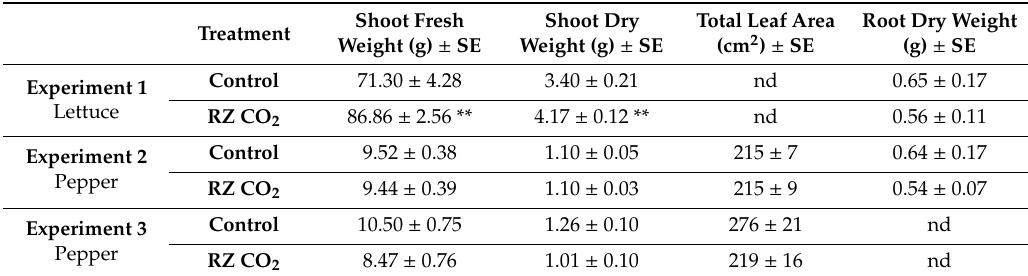
Table 1. Shoot fresh weight, shoot dry weight, total leaf area and root dry weight mean values of lettuce and pepper plants grown aeroponically. Data are the mean ± SE of eight replicates. Asterisks indicate significant di ff erences between treatments (* p < 0.05; ** p < 0.001). nd means not determined. RZ means root zone. Reproduced from